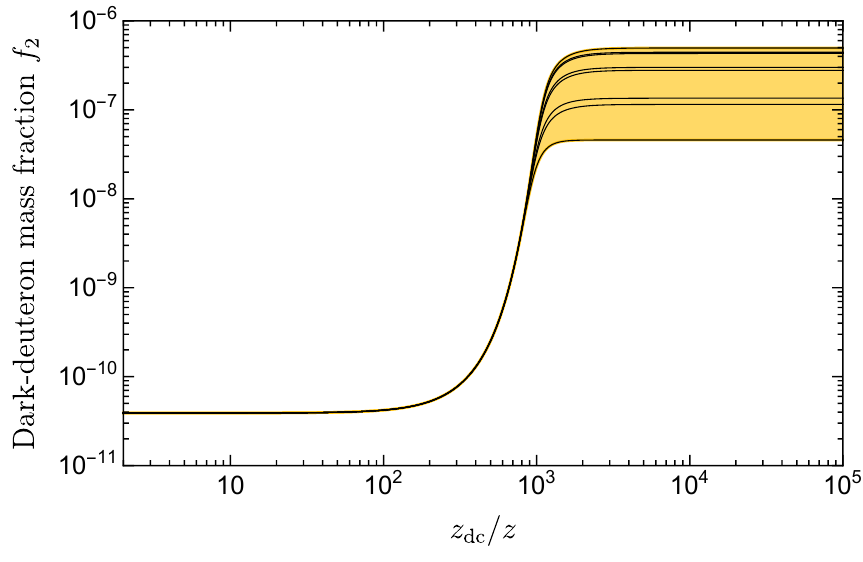
Figure 6 . Dark-deuteron mass fraction f 2 ( z ) in the early universe as a function of the redshift variable z dc =z on a log scale for m (cid:31) = 19 GeV and a = 17 fm. The curves are for 8 values of the 3-body parameter: a + =a = (cid:21) n= 8 with n = 0 ; 1 ; (cid:1) (cid:1) (cid:1) ; 0